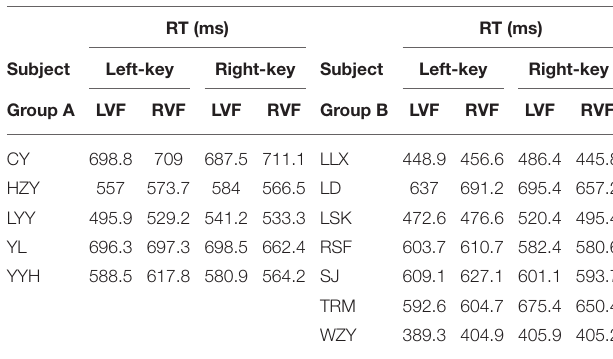
TABLE 2 | The mean RTs under different conditions in color discrimination